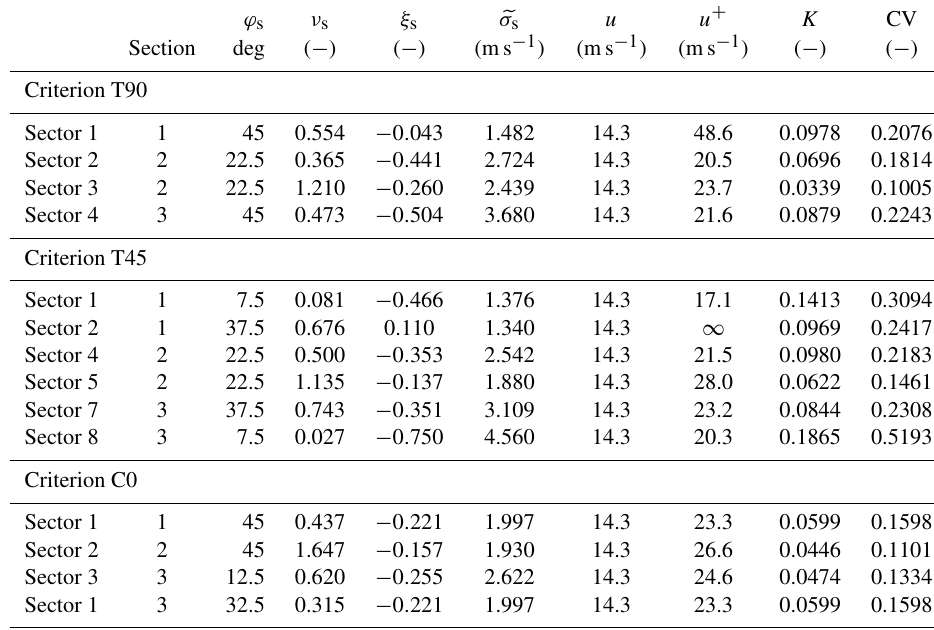
Table 3. Parameters of the optimization problem for criteria T90, T45, and